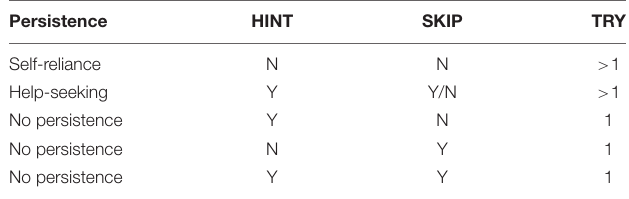
TABLE 2 | Scoring rules for